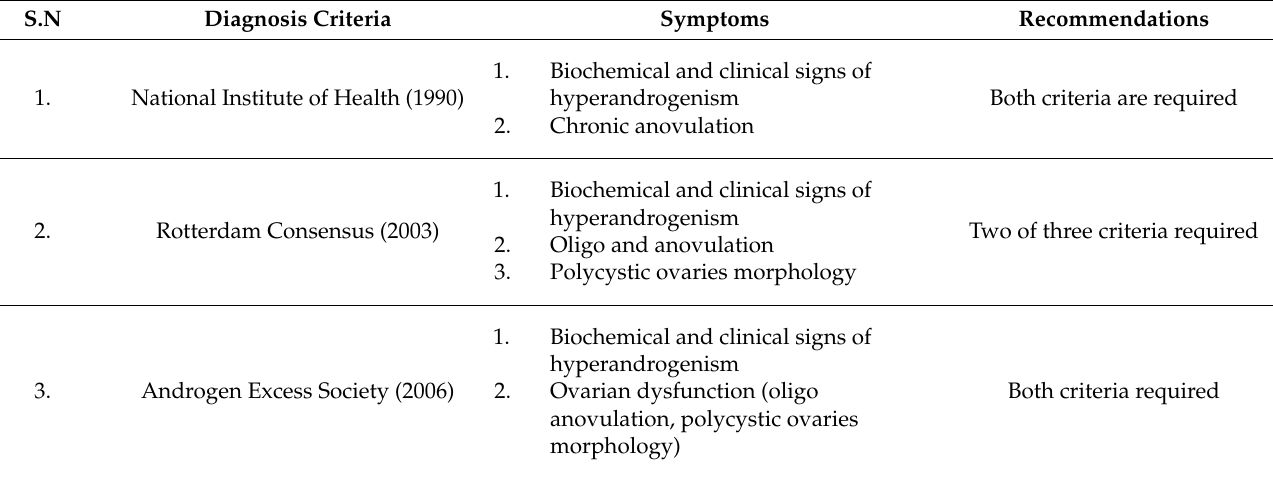
Table 1. Diagnostic Criteria for